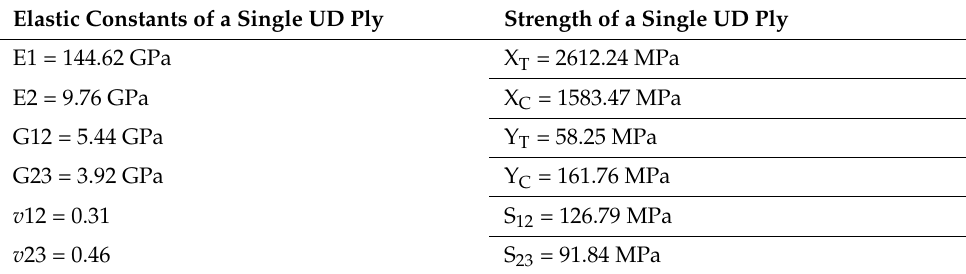
Table 2. Material Properties of a single Unidirectional (UD) Ply. Elastic Constants of a Single UD Ply Strength of a Single UD